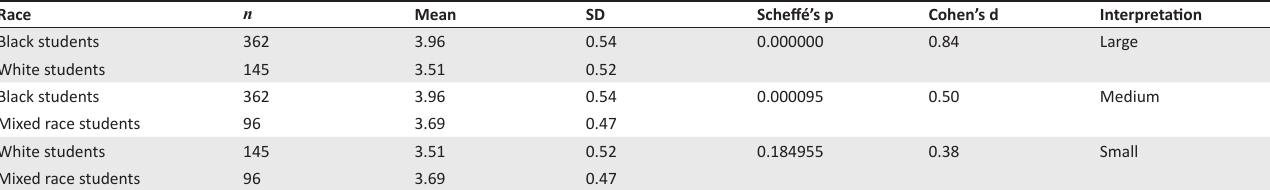
TABLE 5: The practical significance of the impact of race on organisational identification. Race